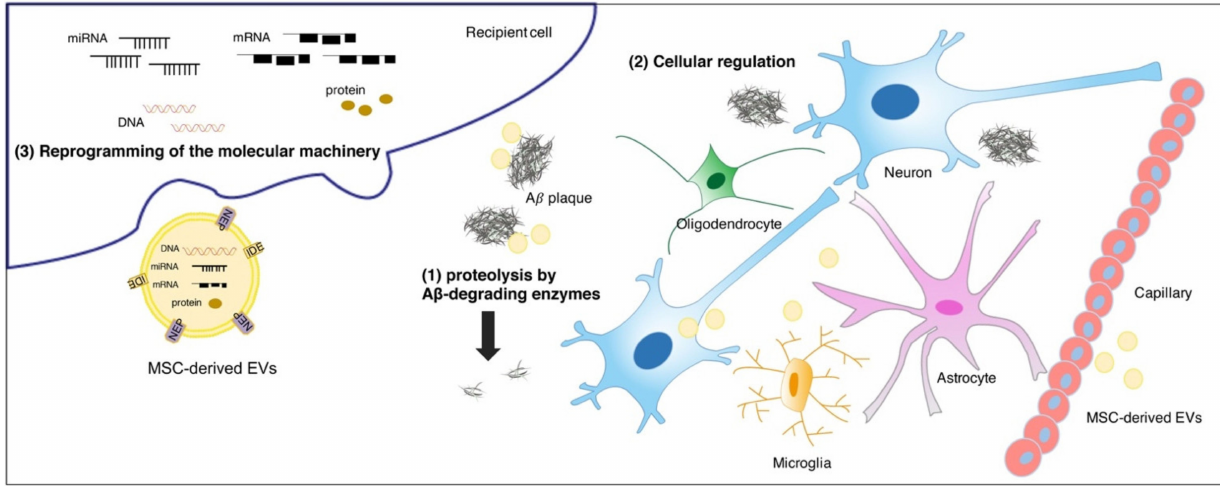
Figure 1. The illustration of potential mechanisms of MSC-derived EVs actions in AD. The therapeutic benefits of MSC- derived EVs are attributed to ( 1 ) the ability to degrade A β s by membrane-bound A β -degrading enzymes, such as NEP and IDE; ( 2 ) the capability to regulate various cells in the brain including immunomodulation or neuroregeneration; ( 3 ) the reprogramming of the molecular machinery in recipient cells via proteins, mRNAs, and miRNAs transferred by